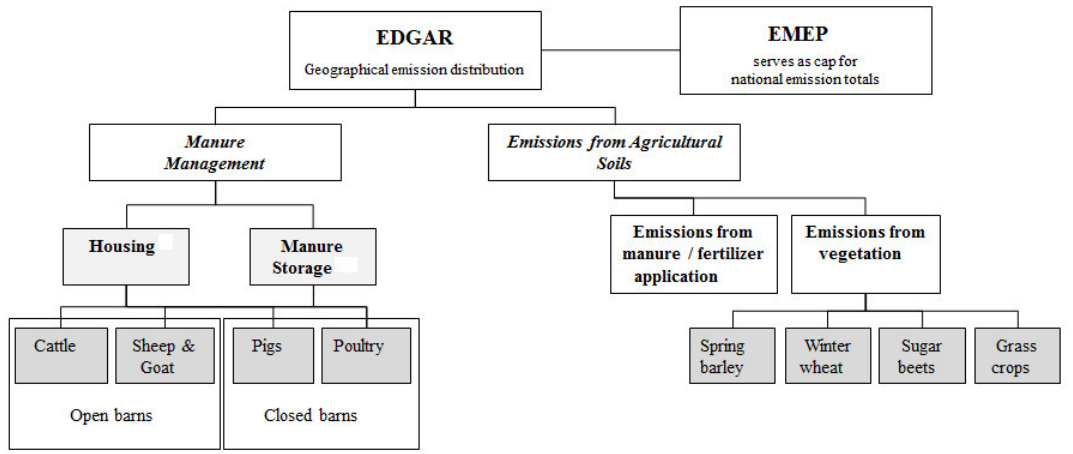
Figure 4. Break-down of agricultural emissions into sub-sectors in order to improve the spatial and temporal distribution (from Backes et al.,